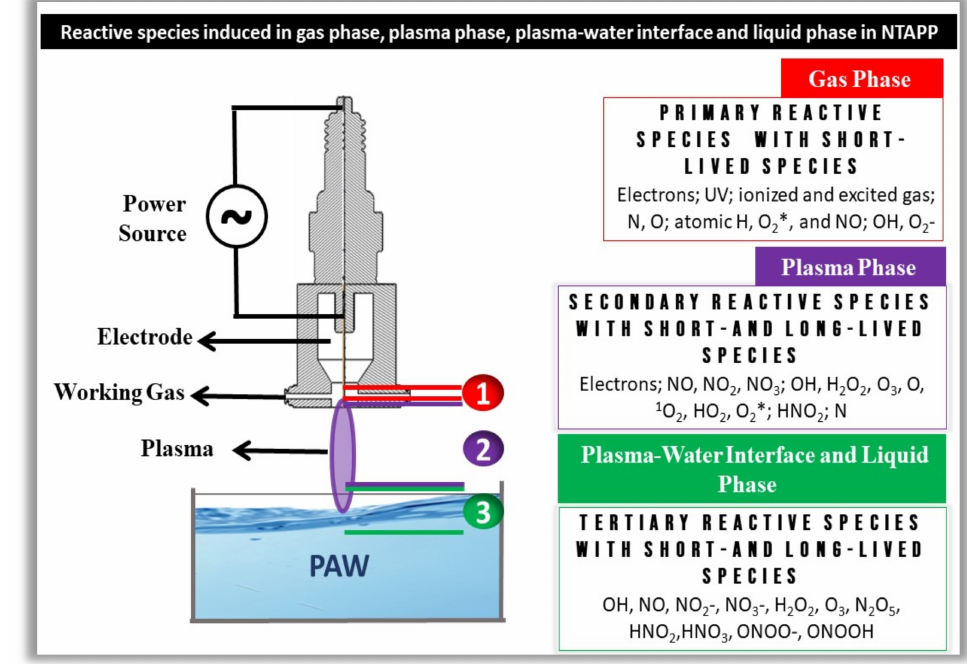
Figure 3. Schematic diagram that shows the regions of reactive species generation induced by NTAPP used to activate water. Note the three regions of RONS formation in an NTAPP device in contact with water. The primary reactive species, short-lived species, electrons and electromagnetic radiation in the ultraviolet range are found in region 1 and are in the gas phase. In region 2, we can observe the secondary reactive species made up of short-lived and long-lived species, and this region is contained in the plasma phase. Tertiary reactive species are short-lived and long-lived species, and their region is limited to the plasma–water interface and liquid